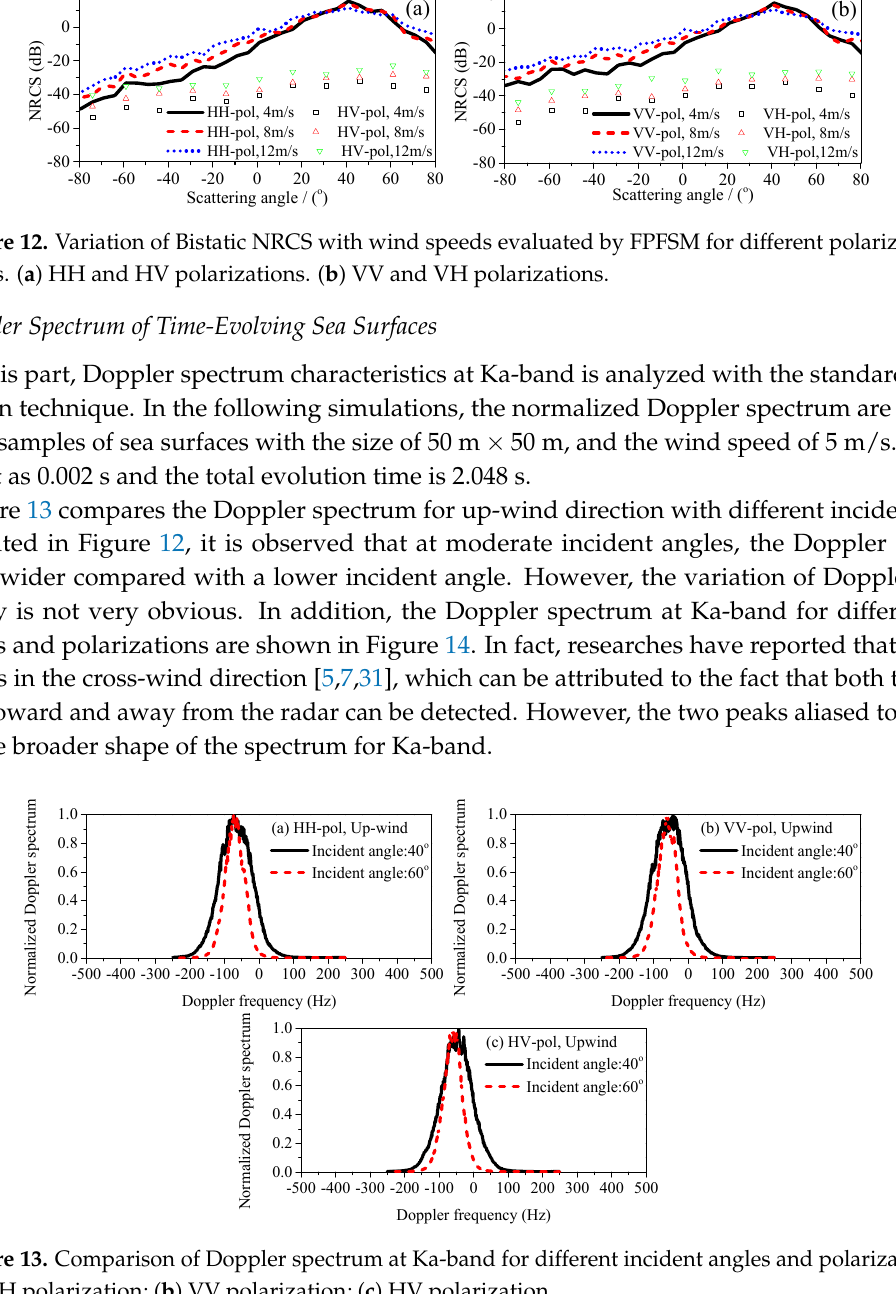
Figure 11. Bistatic NRCS evaluated by FPFSM on the variation of scattering angles. ( a )